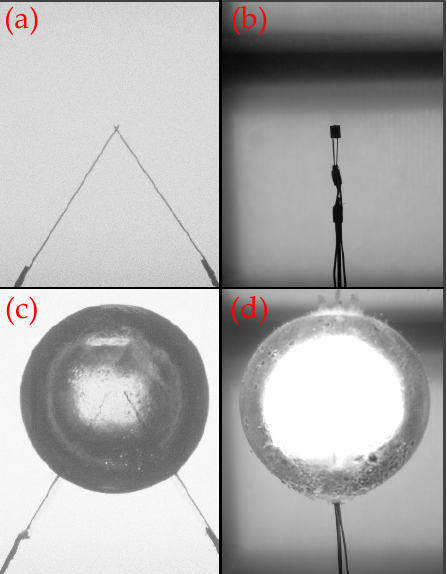
Figure 3. Comparison of spark bubble expansion to maximum volume and explosive bubble expan- sion to maximum volume: ( a ) The state before high voltage discharge; ( b ) The state of the explosive before the explosion; ( c ) The state where the electric spark bubble expands to its maximum volume; ( d ) The state where the explosive bubble expands to its maximum volume.